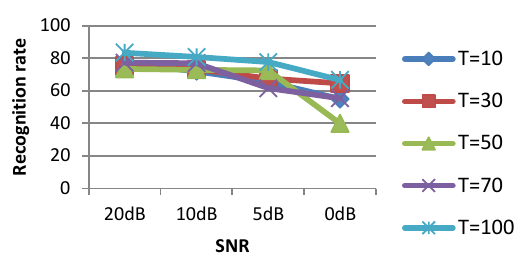
Figure 7. Results which depict that T=100 has the best speech recognition rate.